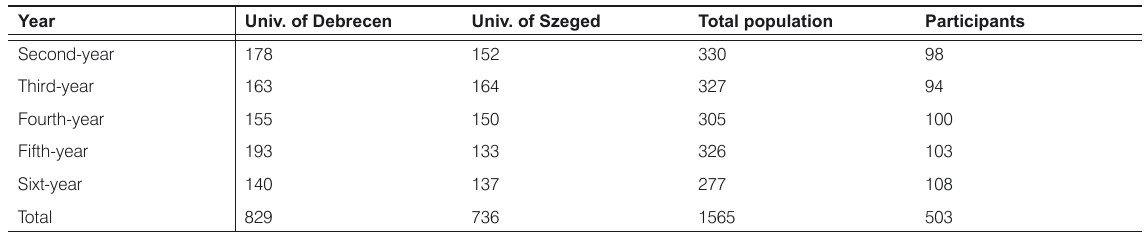
Table 2. Medical students by